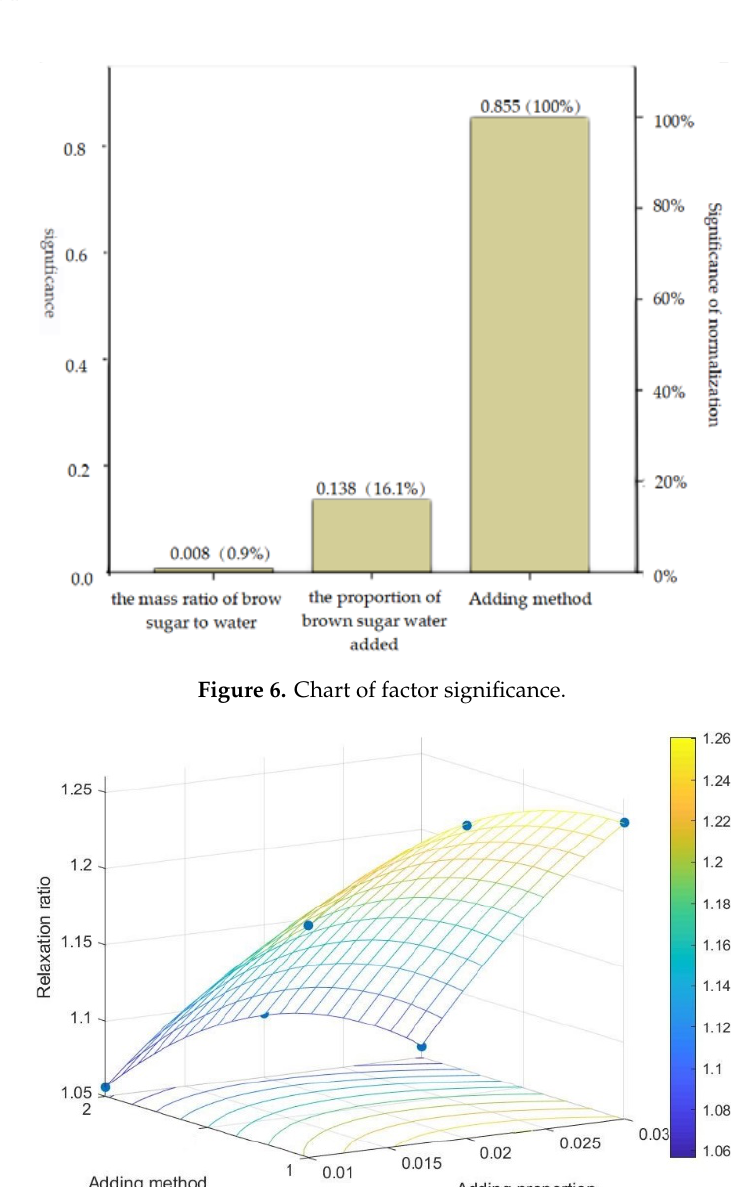
Figure 7. Relation diagram of relaxation ratio–adding proportion and adding method.